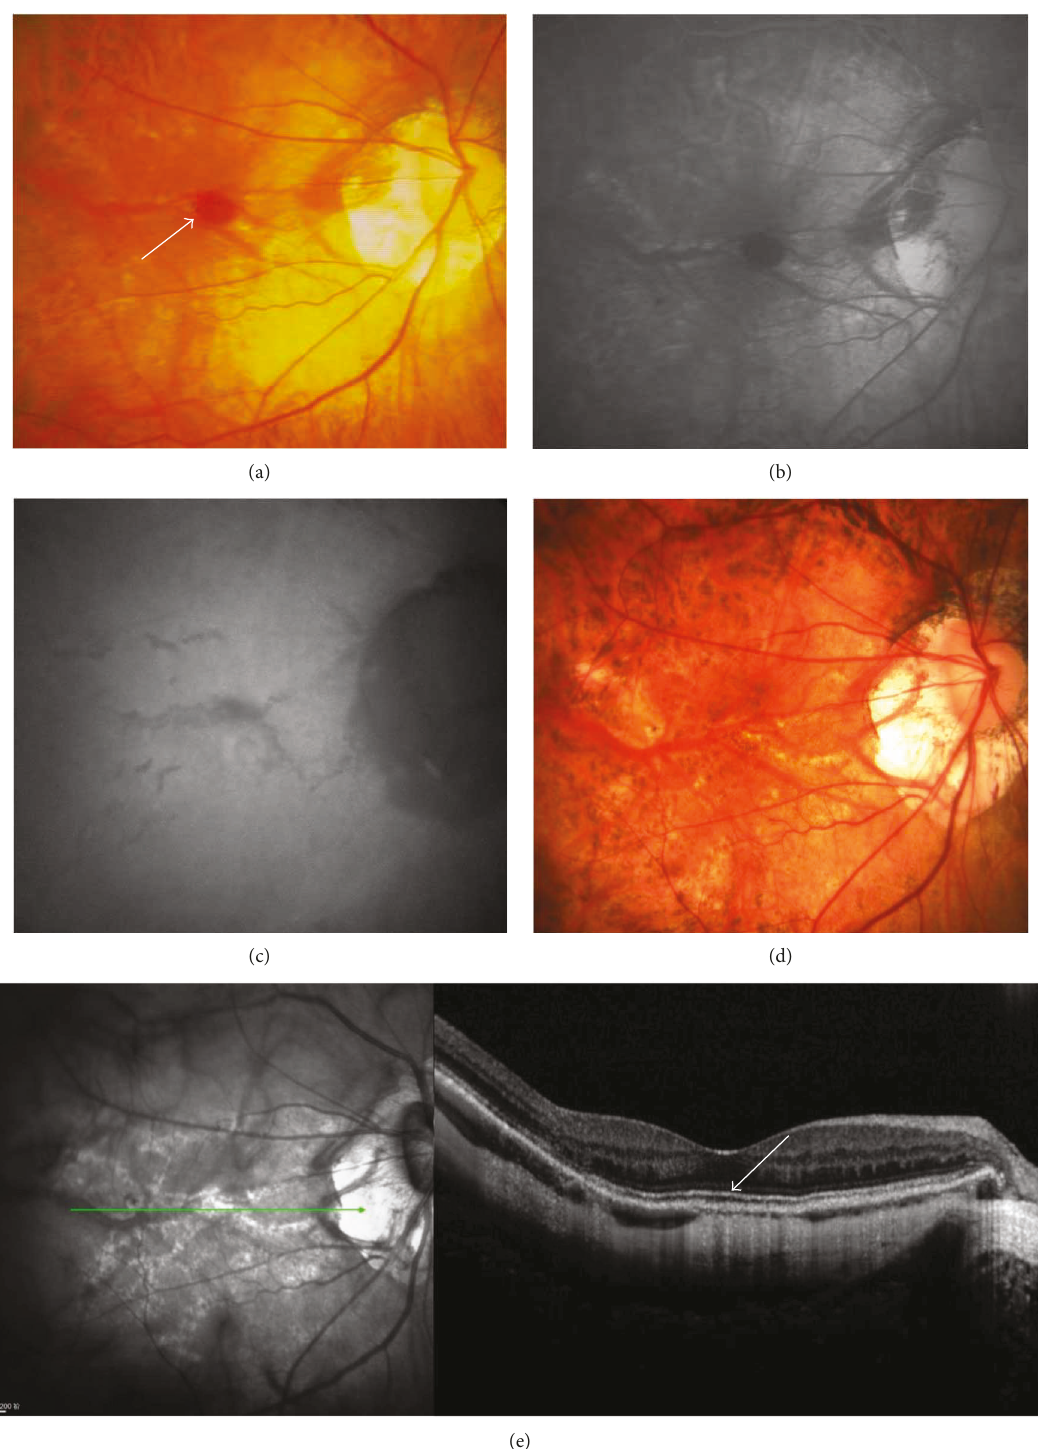
Figure 3: Multimodal imaging of an eye with a continuous ellipsoid zone. A 52-year-old woman was initially seen on September 2, 2011, with decreased visual acuity and a fi xed shadow in her right eye. At the initial examination, the BCVA was 20/100, the refractive error was − 8.75D, and the axial length was 29.7mm in her right eye. There was subretinal hemorrhage (white arrow) in the macular area of the right eye at the initial examination (a). The late phases of FFA and ICGA revealed a simple hemorrhage (b and c). During the follow-up period, recurrent hemorrhage and CNV were not detected. At the fi nal examination (June 2, 2017), LCs were observed in the macular area by color fundus photography (d). An LC passing through the central fovea was easily observed with near-infrared re fl ectance imaging (e). Because the ellipsoid zone (white arrow) at the central fovea was continuous (e), the fi nal BCVA of the eye was still good